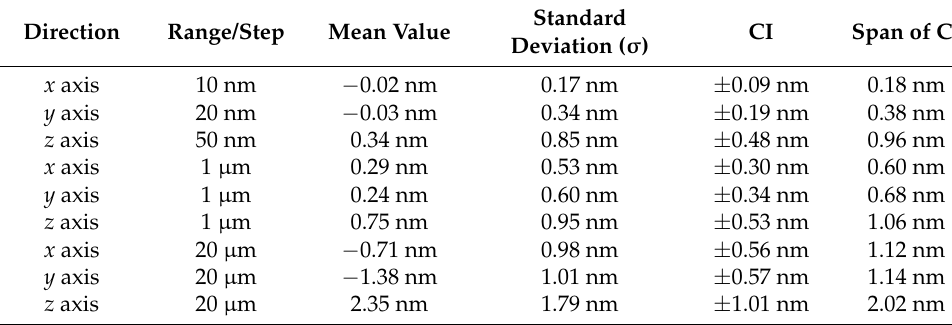
Table 2. Calculation results of the step